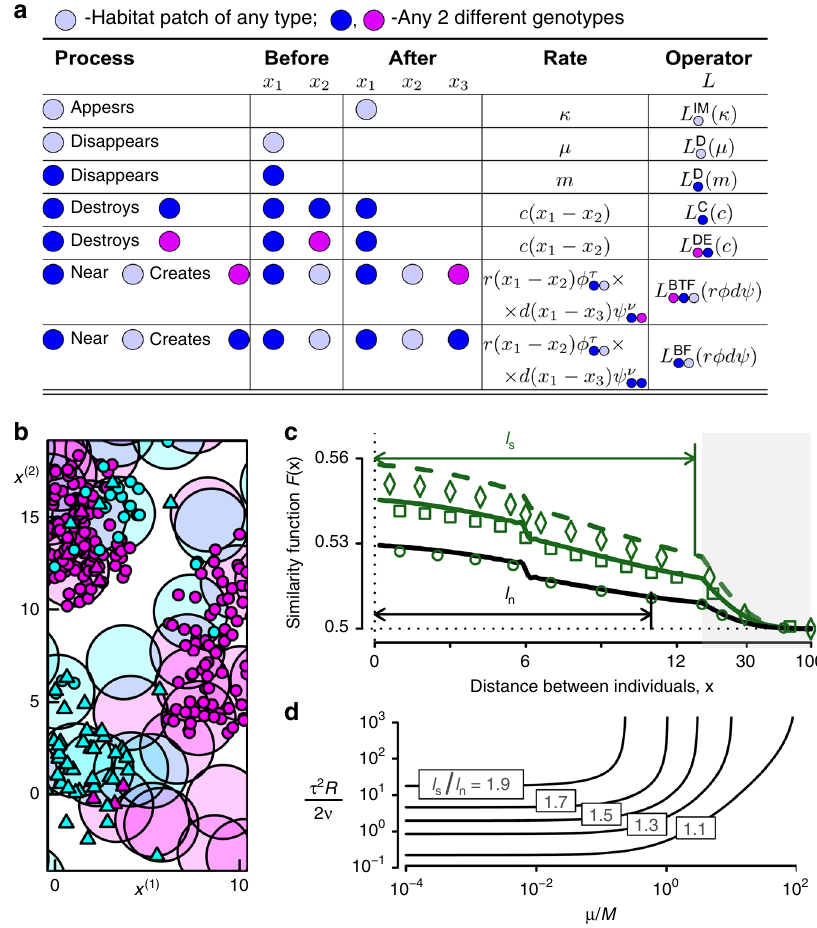
Fig. 4 Spatial patterns of genetic differentiation in heterogeneous environments. a Graphical de fi nition of the population model. b A snapshot of typical dynamics of the model: two types of habitat (light cyan or magenta discs), four genotypes of individuals (small symbols, colour denotes the preferred habitat of allele at selective locus, shape — triangle or circle — denotes allele at neutral locus), see the Methods section for values of parameters. c Similarity function (probability of allelic identity by state) at neutral (black) and selective (green) loci found theoretically (lines) and by simulations (symbols) have different length scales l and l (de fi ned from the fi rst moment of the similarity function). Parameters ð τ ¼ selectionstrength ; μ ¼ habitatturnover Þ equal n s (1, 0.5) for diamonds and the dashed line, (1, 1) for squares and solid green line, and (0.1, 1) for circles and solid black line. Here, at x > 13 a log-scale is used = l (grey area). d When mutation is rare ( ν (cid:6) 1), the factor l by which genetic similarity extends further at the selective locus than at the neutral locus s n depends only on the two parameter combinations τ 2 R (with R ¼ N e ) and M μ . The length scales are most different when selection is strong, mutation rare, 2 ν 2 q h habitat static, and there are many individuals per habitat patch. Error bars not shown as standard errors are smaller than the plotting symbols. Parameter values are given in the Methods